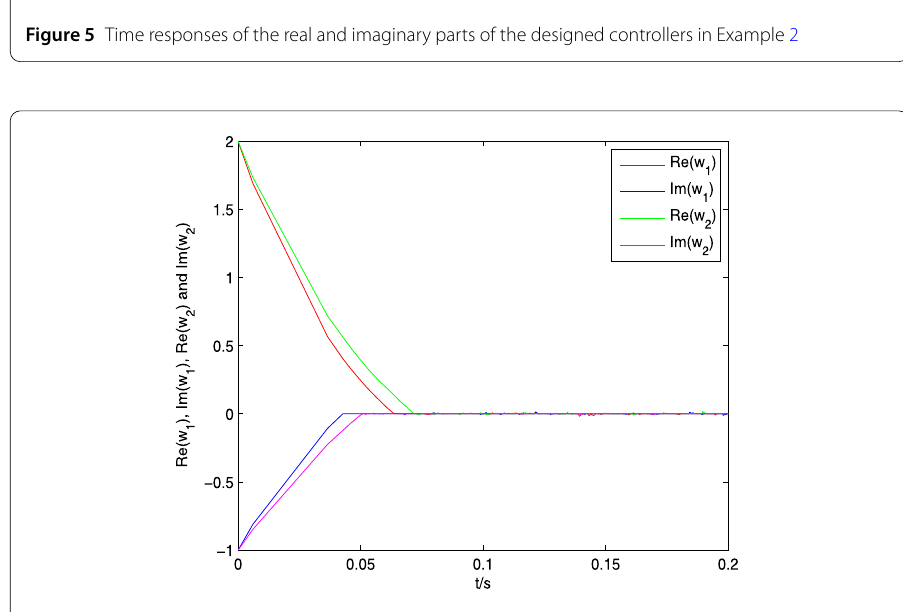
Figure 6 Time responses for the real and imaginary parts of the state solution in Example 2 under the designed